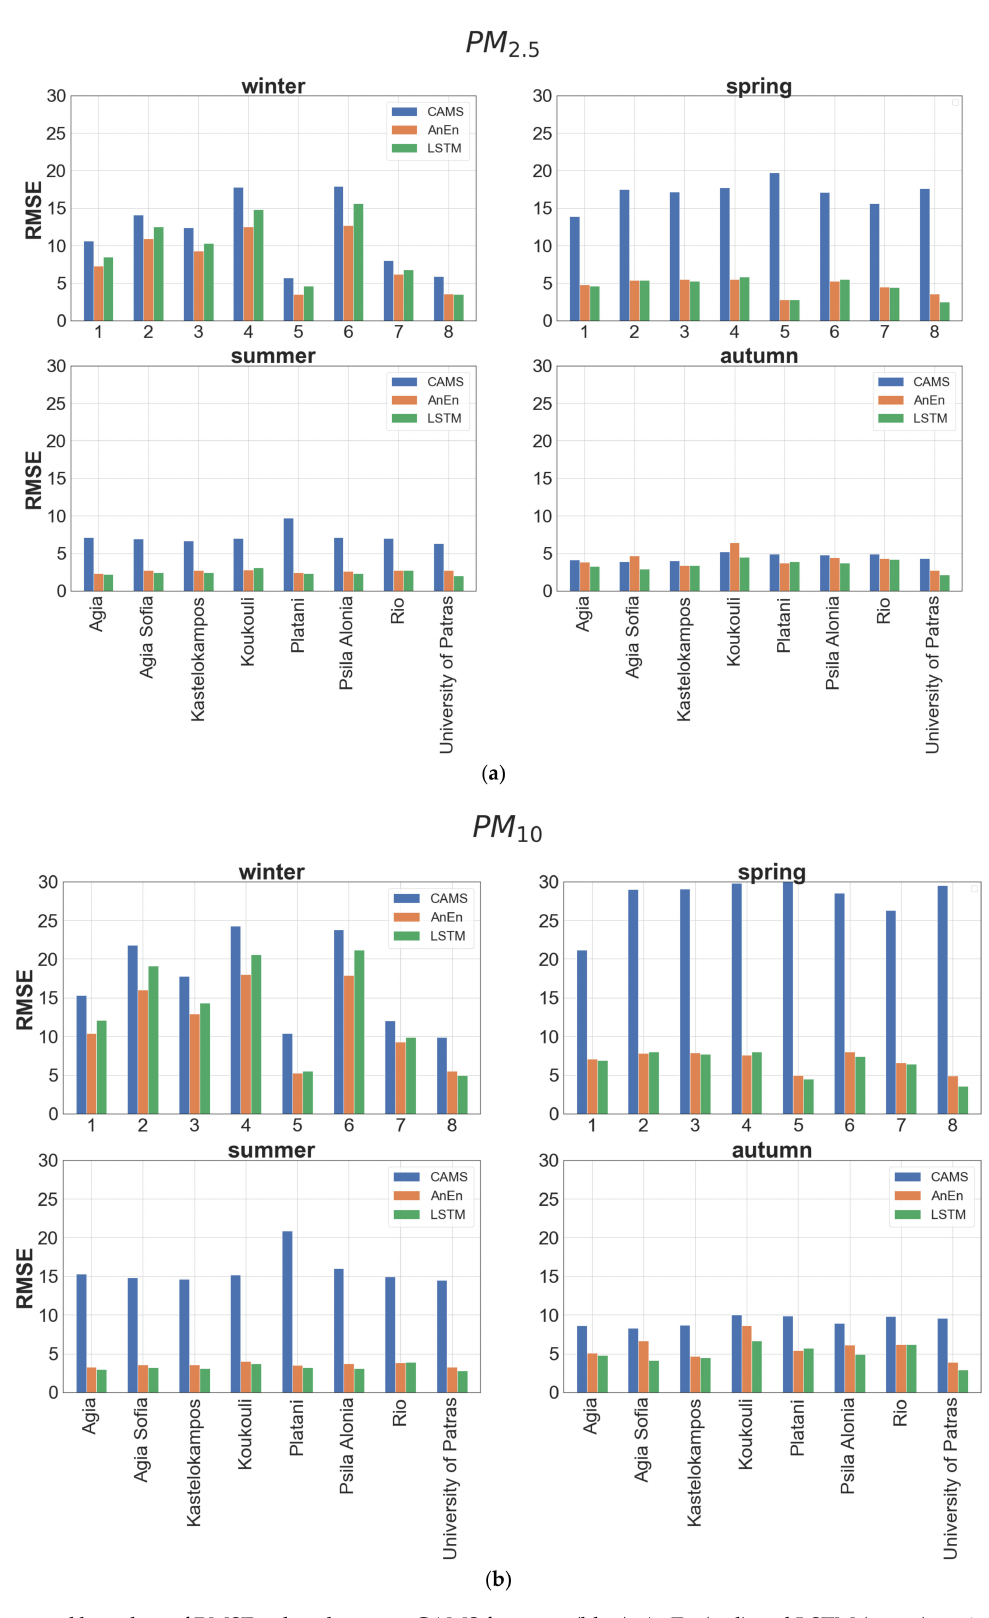
Figure 9. Seasonal bar plots of RMSE values between CAMS forecasts (blue), AnEn (red) and LSTM (green) against observed values for ( a ) PM 2.5 and ( b ) PM 10 at each